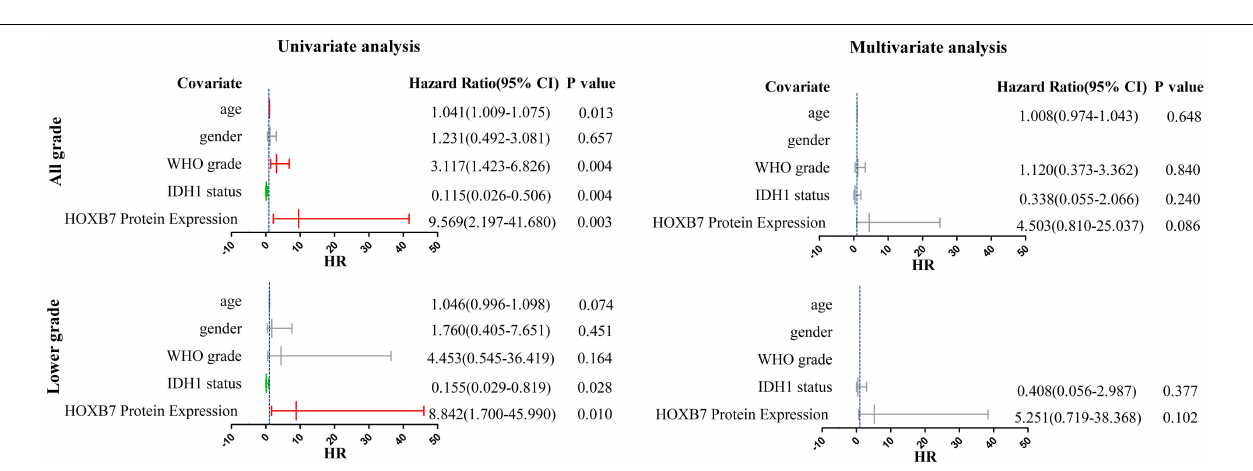
Frontiers in Cell and Developmental Biology |